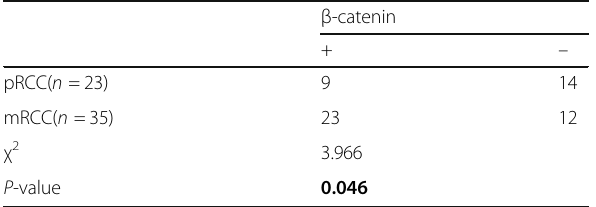
Table 5 χ 2 test of the expression of β -catenin in pRCCs and mRCCs